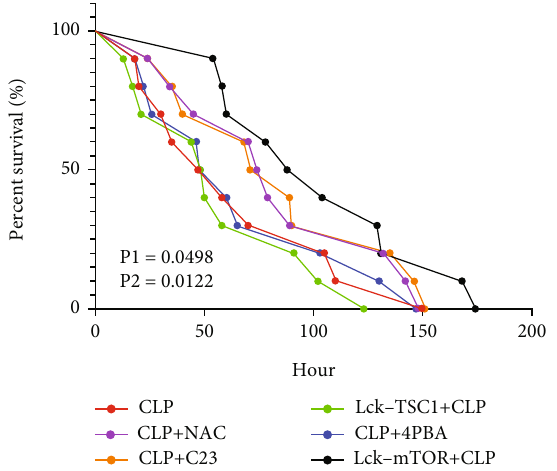
Figure 2: Survival curves. Survival rates between CLP, CLP+NAC, CLP+C23, CLP+4-PBA, Lck-TSC1+CLP, and Lck-mTOR+CLP groups. During the fi rst 18 hours after CLP operation, the survival conditions were regularly monitored every 2 hours and then observed every 6 hours. Median survival time of CLP was 64h, and LCK-TSC1+CLP group was 56h, while Lck-mTOR +CLP had a signi fi cantly prolonged median survival time of 104h (Kaplan-Meier with log rank test). n = 10 -14 mice per group. x -axis: survival time; y -axis: survival rate. P1=LCK-TSC1+CLP vs. Lck-mTOR+CLP; P2 =CLP vs. Lck-mTOR+CLP. NAC =N- acetyl-L-cysteine; 4-PBA =sodium phenylbutyrate; C23 =CIRP- Ab; CIRP=cold-inducible RNA-binding